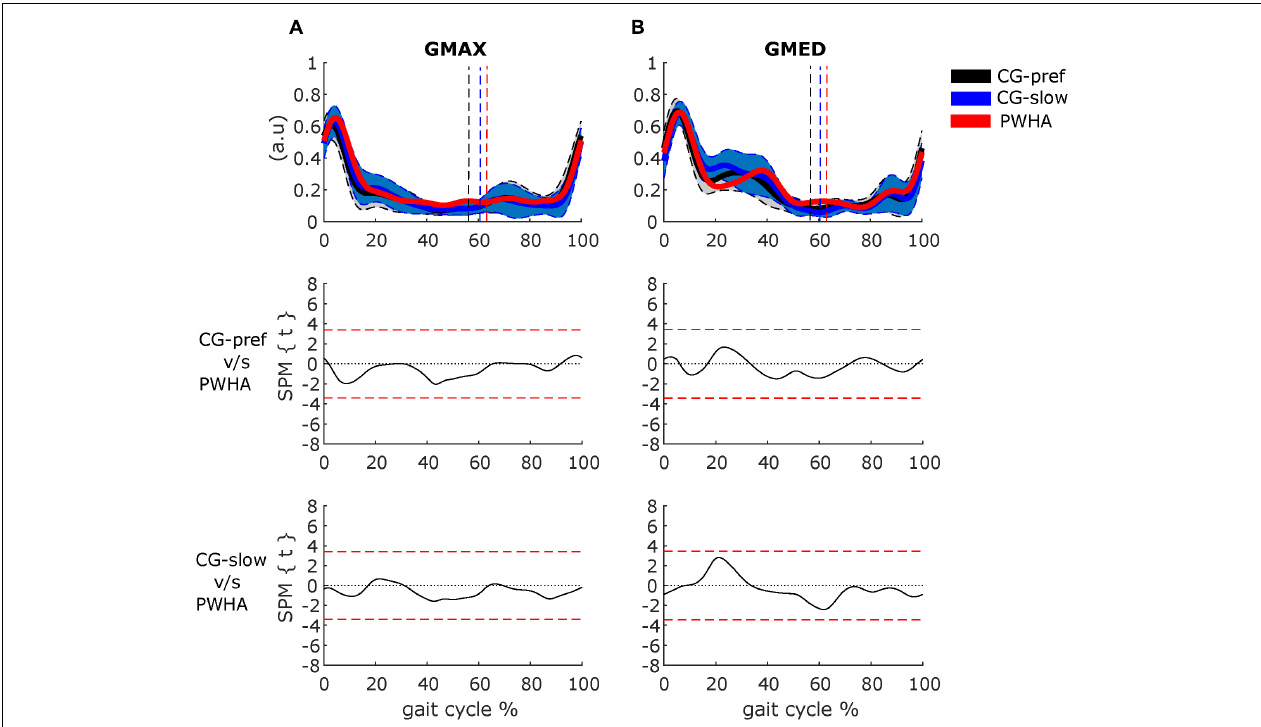
FIGURE 4 | Comparison between groups of surface electromyography of muscles crossing the hip. (A) Gluteus maximus (GMAX). (B) Gluteus medius (GMED). (Top row) Surface electromyography of muscles crossing the hip of people with hemophilic arthropathy (PWHA; n = 14) at their preferred velocity (red), the control group ( n = 13) at their preferred velocity (CG-pref, black), and during the slow velocity condition (CG-slow, blue). Data are plotted as a function of normalized step time (0, heel strike) and expressed as mean with 95% confidence interval for CG. Vertical dashed lines indicate transition from stance to swing phase (black, CG-pref; blue, CG-slow; red, PWHA). (Bottom two rows) Time-dependent t values of the statistical parametric mapping (SPM) for groups comparison. Horizontal red dashed line indicates p = 0.05 level. Gray zones indicate regions with statistically significant differences. a.u, Arbitrary